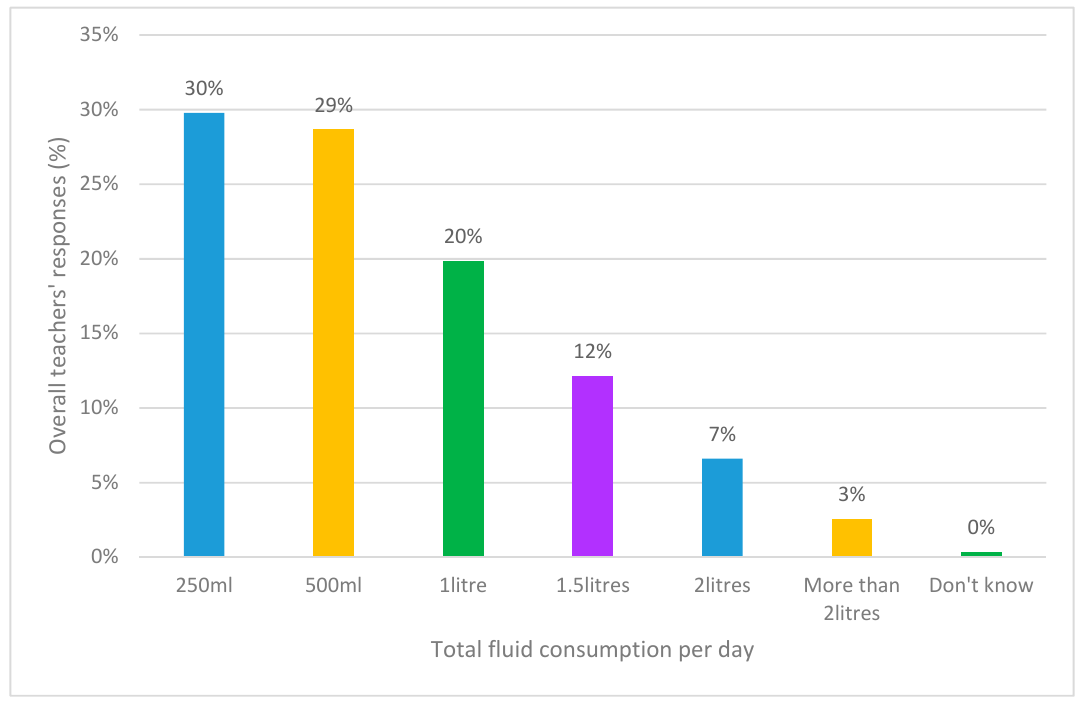
Figure 2. Teachers’ reported consumption of fluid per day.